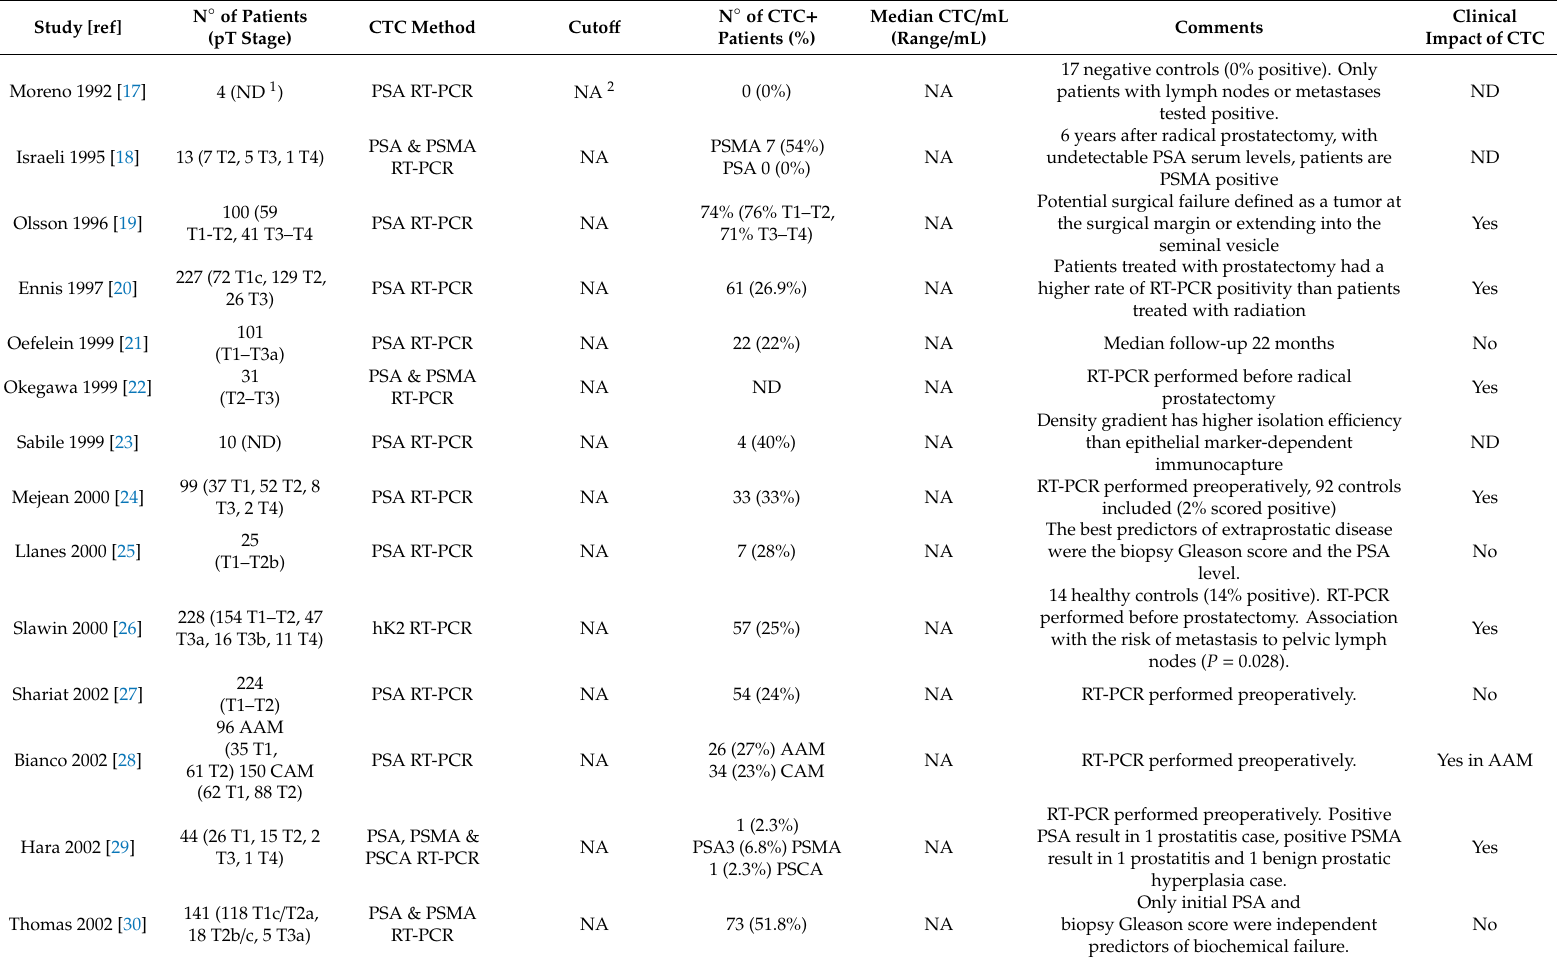
Table 1. Studies on circulating tumor cells in patients with non-metastatic prostate